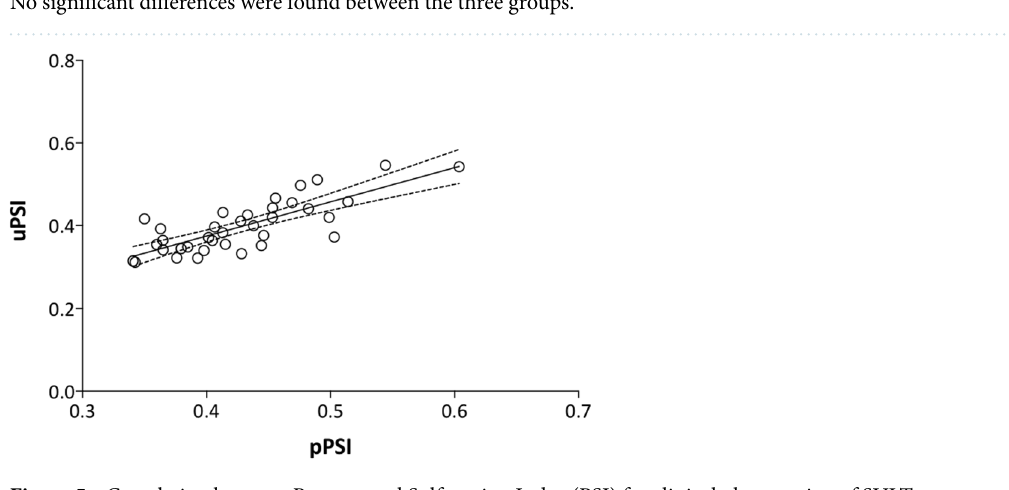
Figure 5. Correlation between Paracetamol Sulfonation Index (PSI) for clinical phenotyping of SULT measured in plasma and urine samples. We found a good correlation between plasma and urinary PSI (Pearson’s correlation coefficient = 0.79, p <